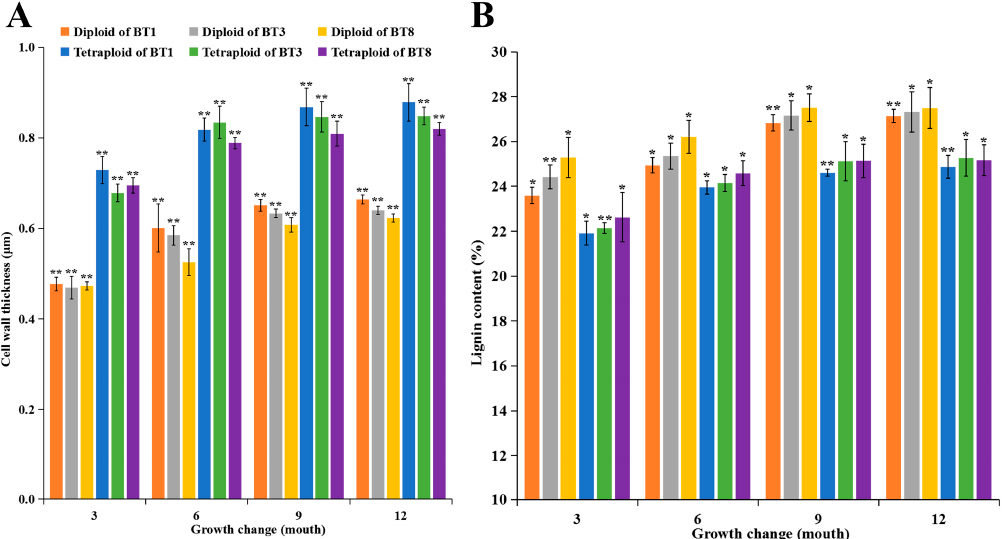
Figure 3. The cell wall thickness ( A ) and lignin content ( B ) of 3-, 6-, 9-, and 12-month-old diploid and tetraploid plants of P. hopeiensis . The vertical bars show the standard error; the asterisk indicates signi fi cant di ff erences between diploid and tetraploid plants (* p < 0.05, ** p < 0.01).